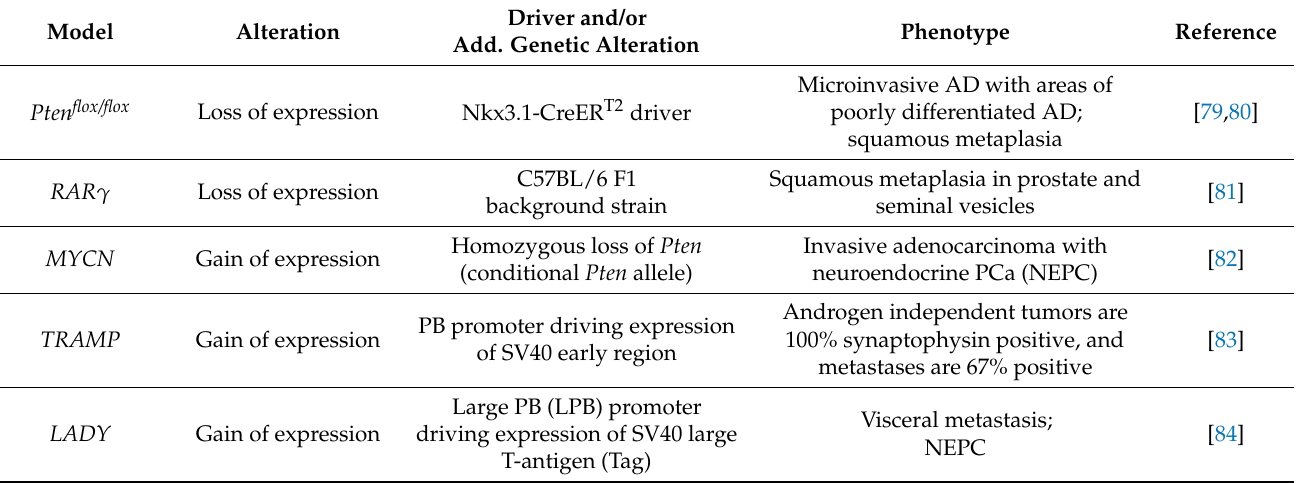
Table 6. PCa models in which squamous cell carcinoma, neuroendocrine carcinoma, and sarcomatoid carcinoma are